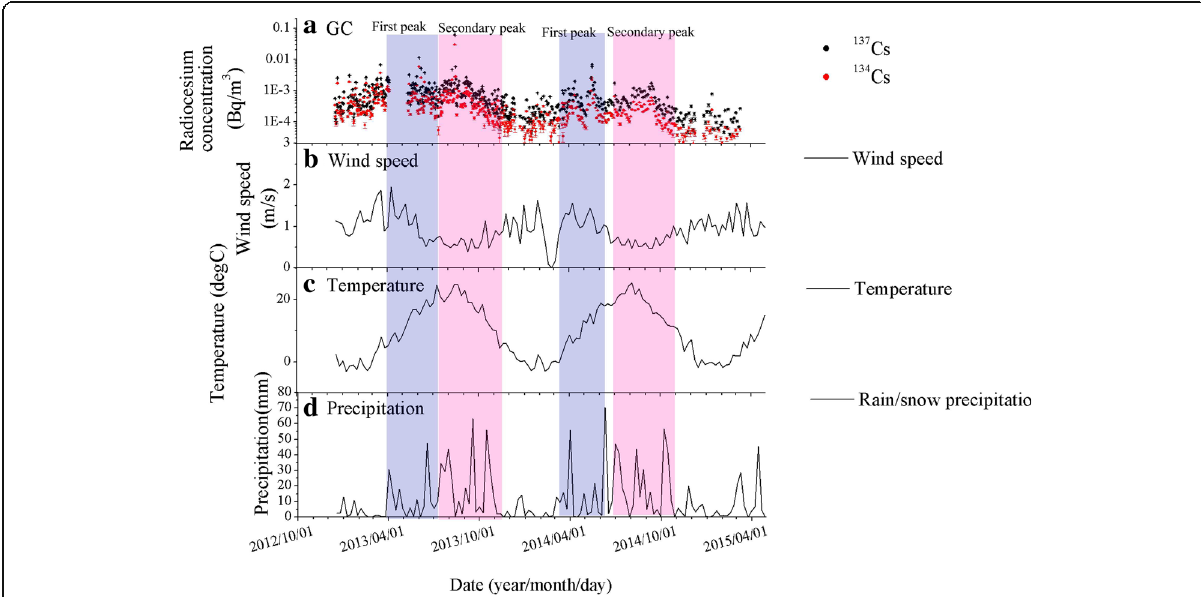
Fig. 3 Time series of ( a ) radiocesium concentrations, ( b ) wind speeds, ( c ) temperatures, and ( d ) rain/snow precipitation. At the GC site, we can see two maxima in the higher concentration seasons: in May and September. The first maxima occurred with wind speed peaks, and the second maxima occurred with atmospheric temperature